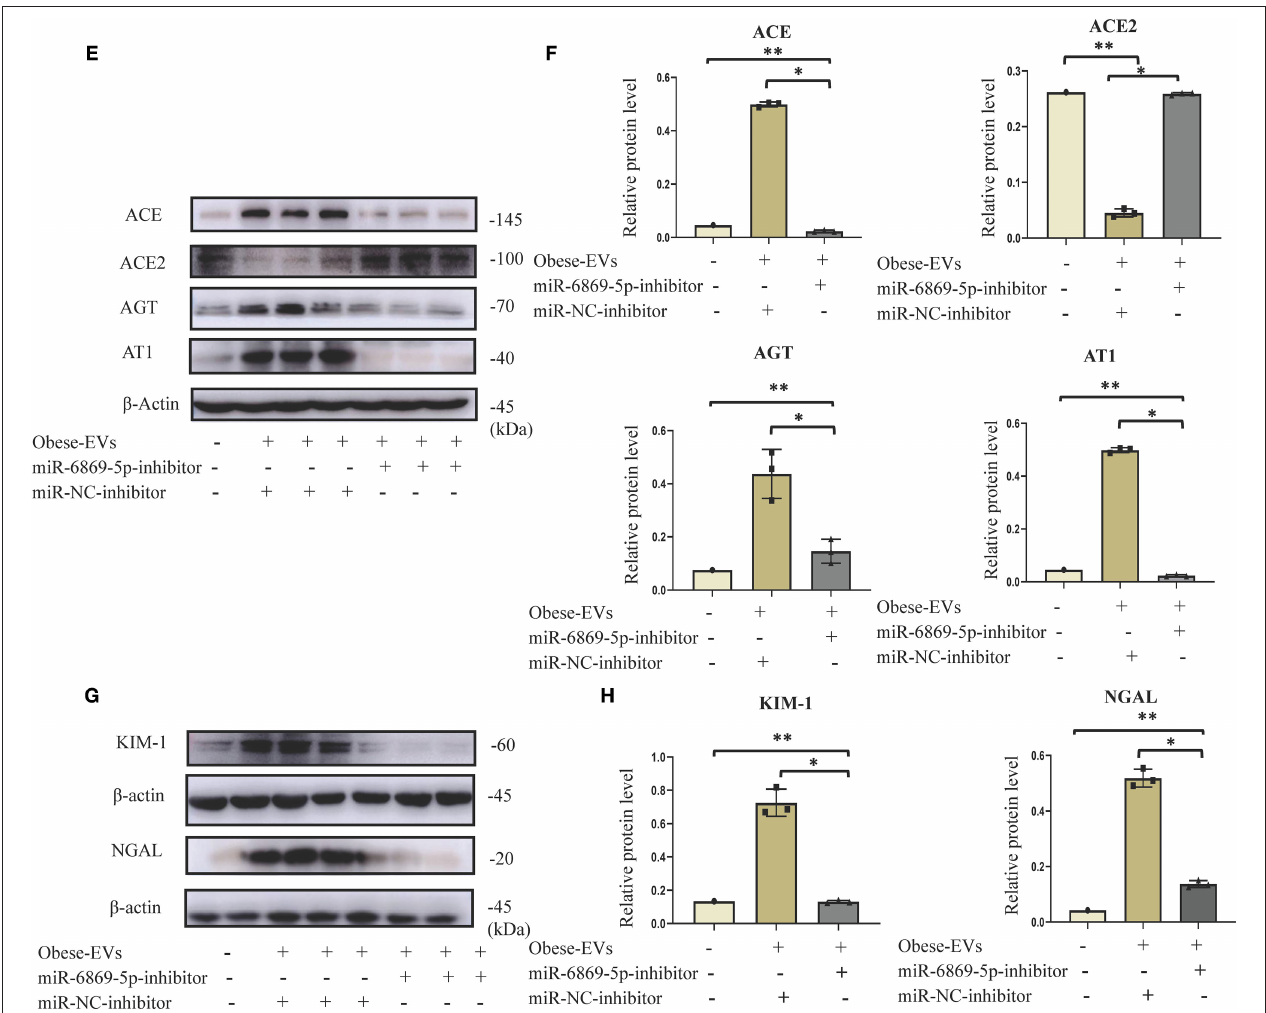
FIGURE 6 | Plasma Obese-EVs induce renal tubule injury and RAS activation in PTECs via transport of miR-6869-5p. (A–D) After in vitro transfection of miR-6869-5p mimic and miR-NC-mimic, the protein levels of AGT, ACE, ACE2, AT1 (A,B) , KIM-I, and NAGAL (C,D) were analyzed by Western blotting ( n = 3). (E,F) After transfection with miR-6869-5p inhibitor or miR-NC-inhibitor for 48h, PTECs were treated with PBS, Lean-EVs, or Obese-EVs. The protein levels of AGT, ACE, ACE2, AT1 (E,F) , KIM-I, and NGAL (G,H) were analyzed by Western blotting ( n = 3). Data are presented as mean ± SD; ** P < 0.001 vs. PBS, * P < 0.001 vs. Lean-EVs. EVs, extracellular vesicles; PTECs, Proximal tubular epithelial cells; AGT, angiotensinogen; ACE, angiotensin-converting enzyme; ACE2, angiotensin-converting enzyme 2; AT1, angiotensin 1; KIM-1, kidney injury molecule-1; NGAL, neutrophil gelatinase-associated